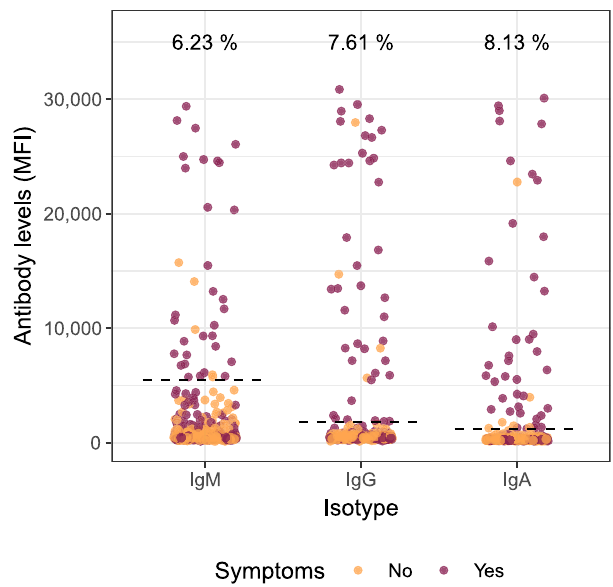
Fig. 2 SARS-CoV-2 antibody levels in all study participants. Dots depict the levels (median fl uorescence intensity, MFI) of IgM, IgG, and IgA against Receptor Binding Domain (RBD) of the SARS-CoV-2 Spike glycoprotein. Dashed lines indicate the seropositivity threshold calculated with pre- pandemic controls as the 10 to the mean plus 3 standard deviations of log 10 -transformed MFIs. The percentage of seropositive subjects is shown for each antibody isotype. Orange and burgundy dots show subjects who did not have or did have history of at least one COVID-19 compatible symptom, respectively. N =